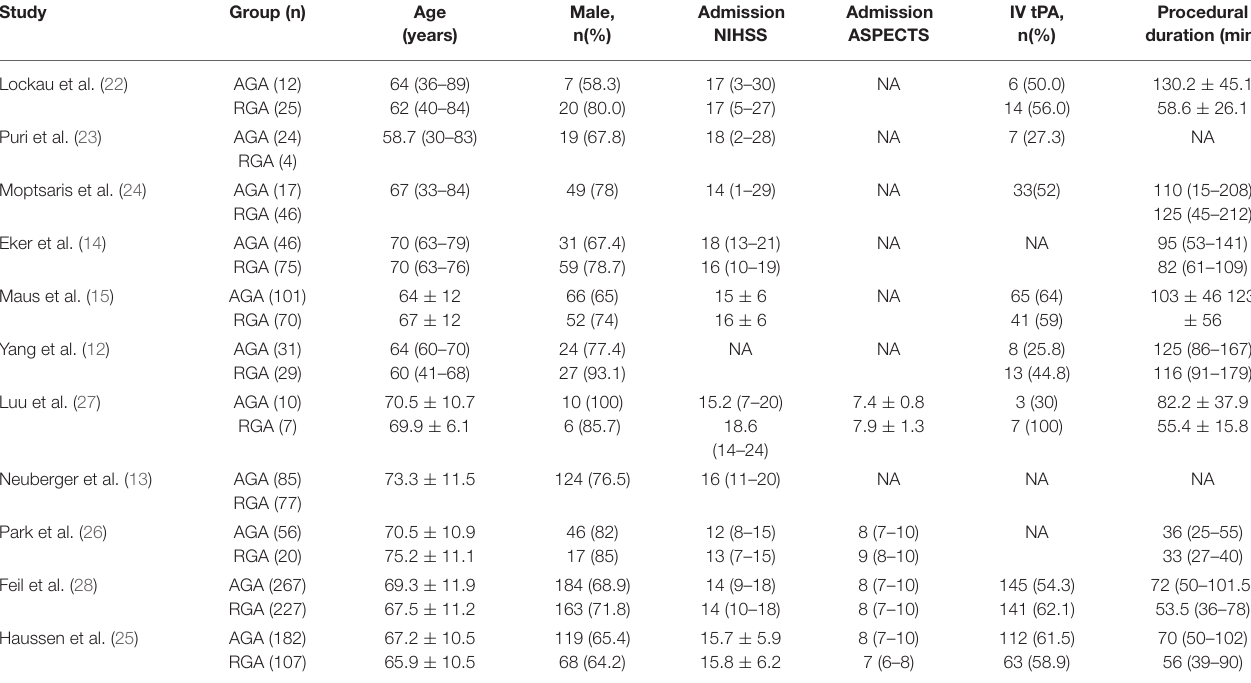
TABLE 2 | Main baseline data of included